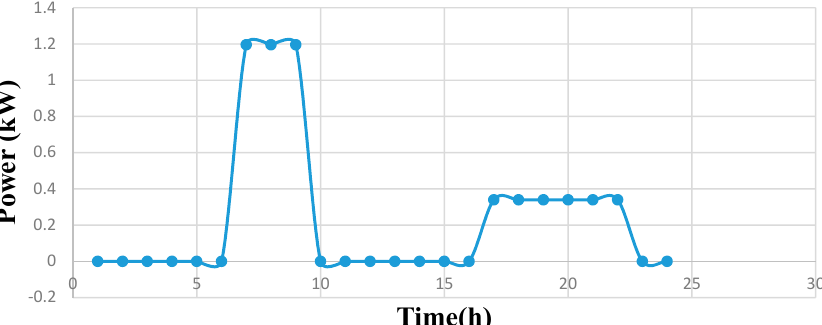
Figure 3. Hourly demand for Gwakwani based on the aforementioned devices.